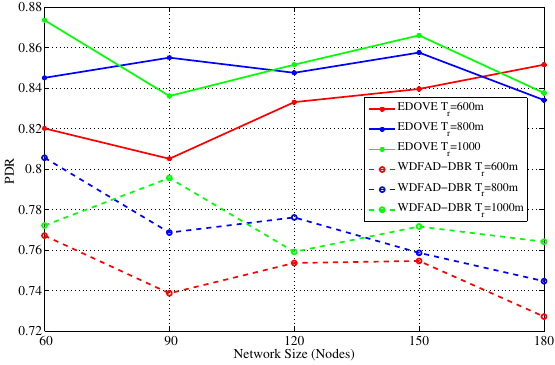
Figure 8. Average packet delivery ration versus the network sizes.